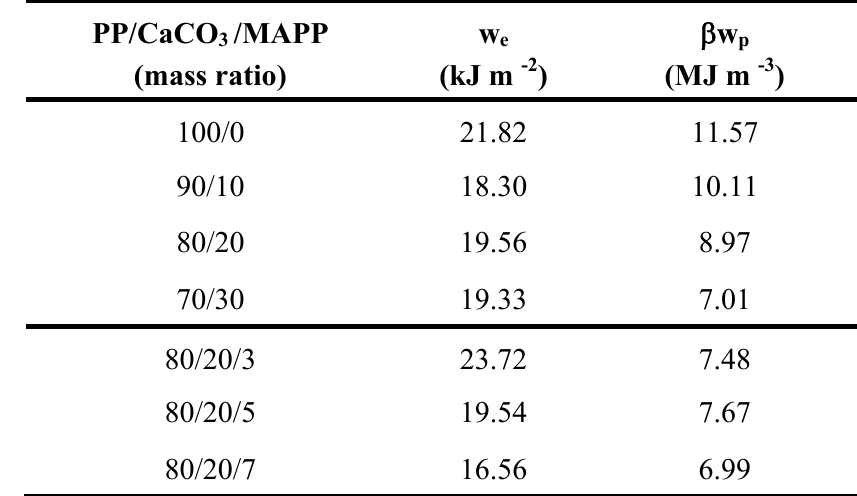
Table 4. EWF parameters obtained from PP-CaCO MAPP. (adapted from